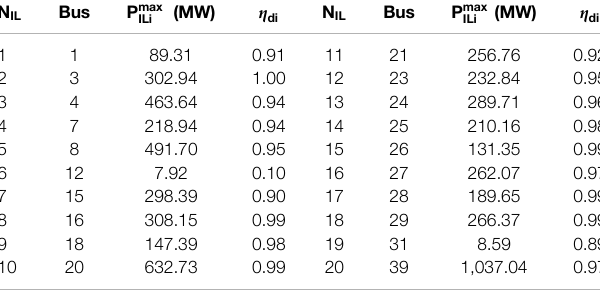
TABLE 2 | Data for interruptible loads.